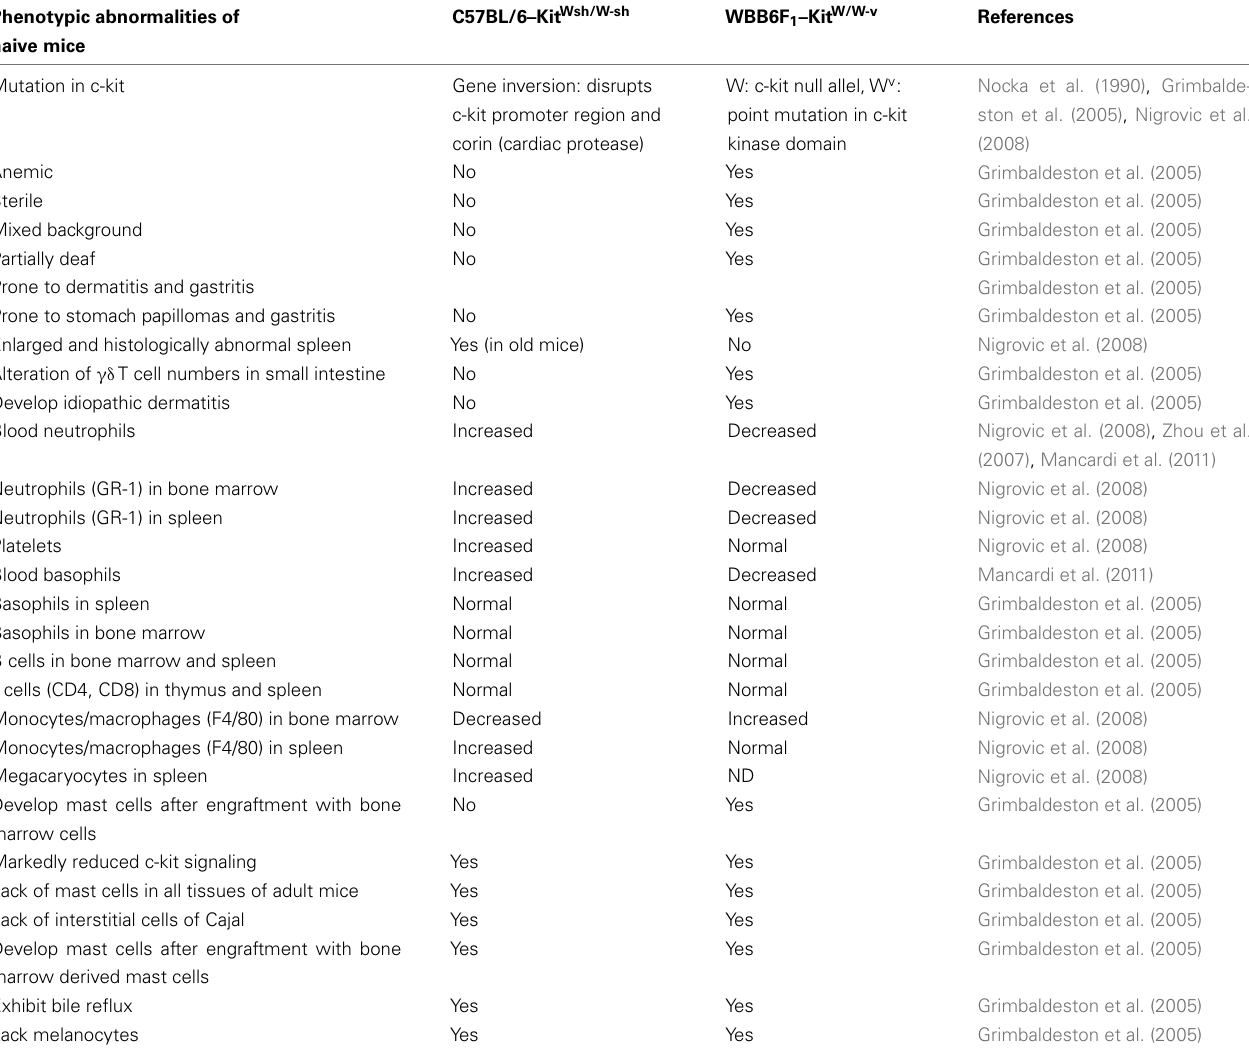
Table 1 | Comparison of phenotypic abnormalities in mast cell-deficient C57BL/6–Kit Wsh/W-sh andWBB6F 1 –Kit W/W-v mice as compared to wild-type